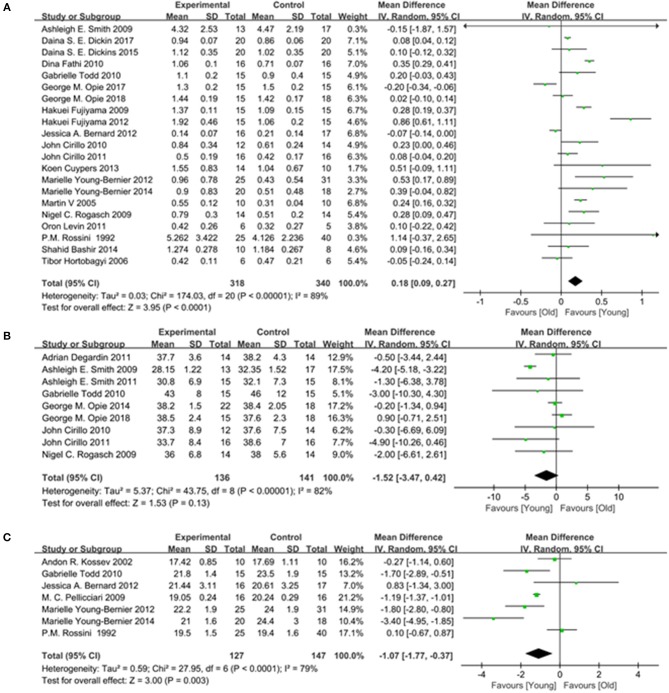
Young group vs. old group, Secondary outcomes. (A) Forest plot of the MEP amplitude. (B) Forest plot of the MEP Latency. (C) Forest plot of the AMT.